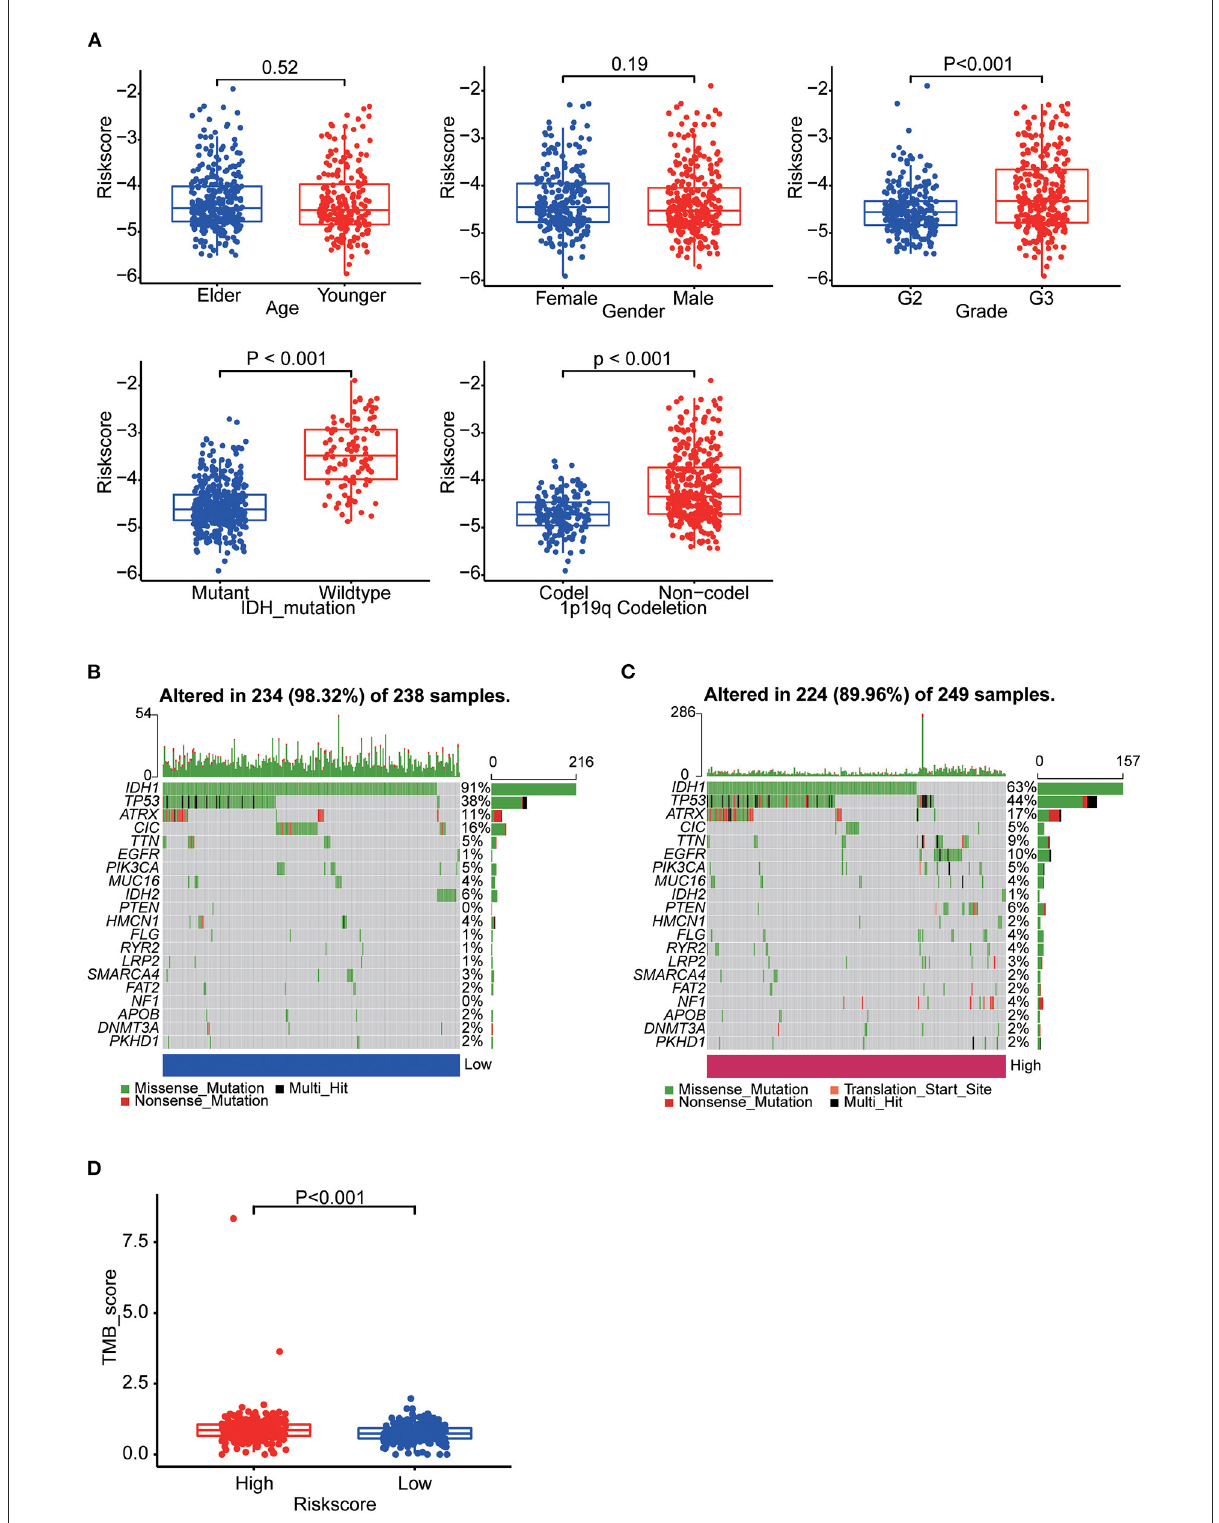
FIGURE6 (A) Boxplots showing the distribution of risk scores in LGG samples categorized by age, sex, WHO grade, IDH mutation status and Chr1p19q co-deletion status. (B) The somatic landscape of low-risk group samples. (C) The somatic landscape of high-risk group samples. Mutation information for each gene in each sample is shown as waterfall plots, with different colors at the bottom with specific annotations indicating various mutation types. (D) Boxplot showing the difference of TMB scores between two